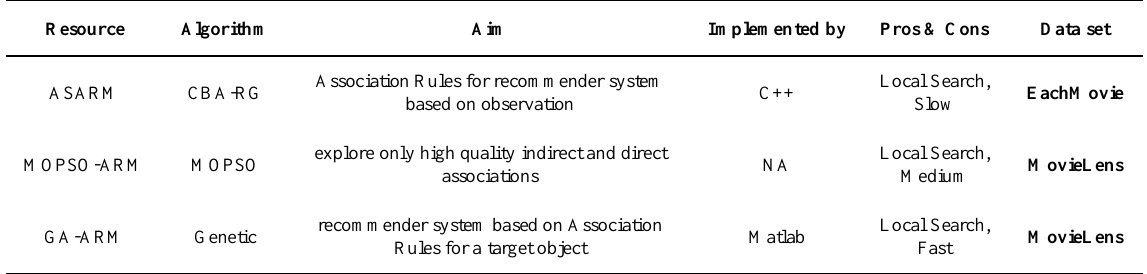
Table 1. Review of the proposed